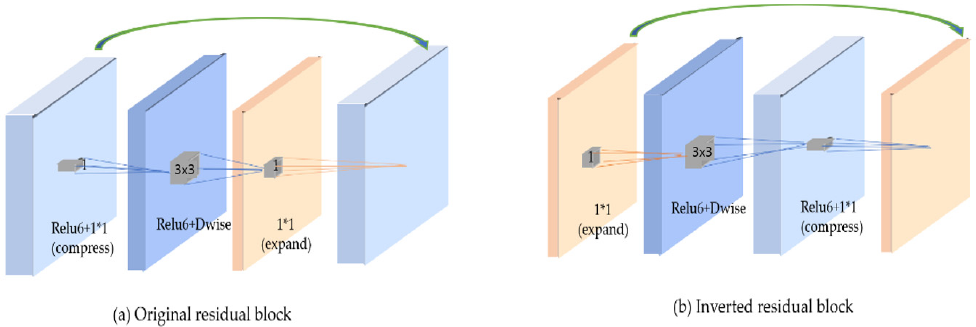
Figure 6. Configuration of the inverted residual block [12].